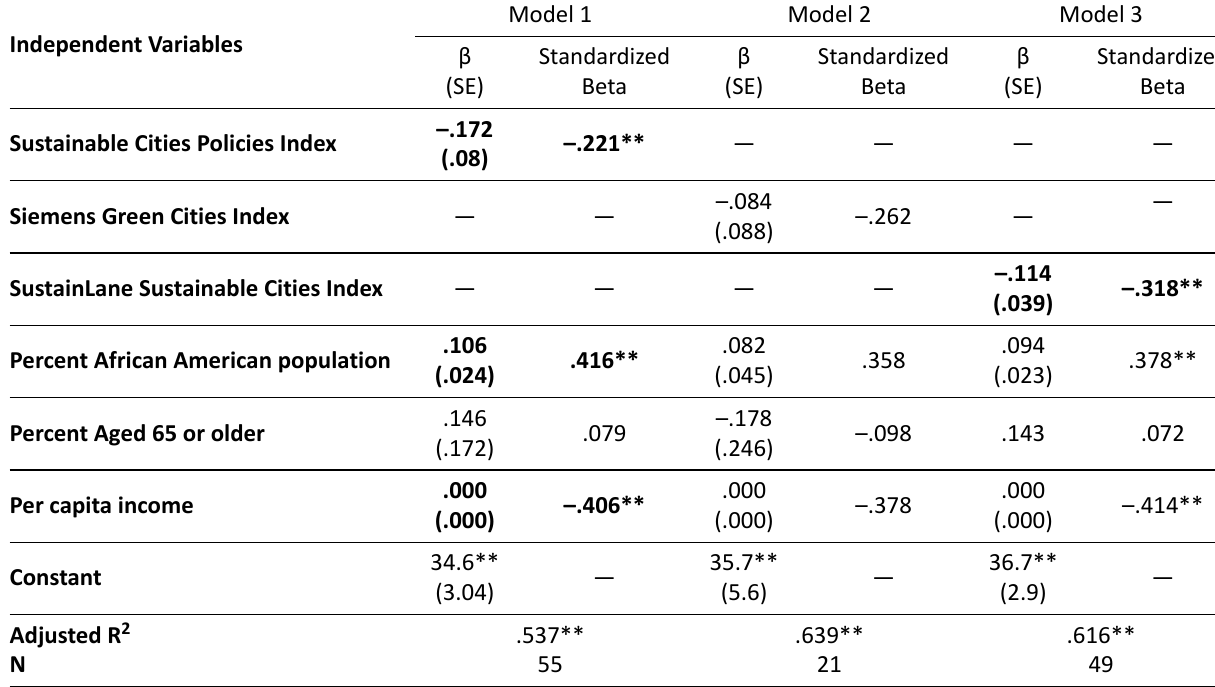
Table 3. OLS regression results showing the effects of sustainability on obesity levels (percent with BMI over 30) in large